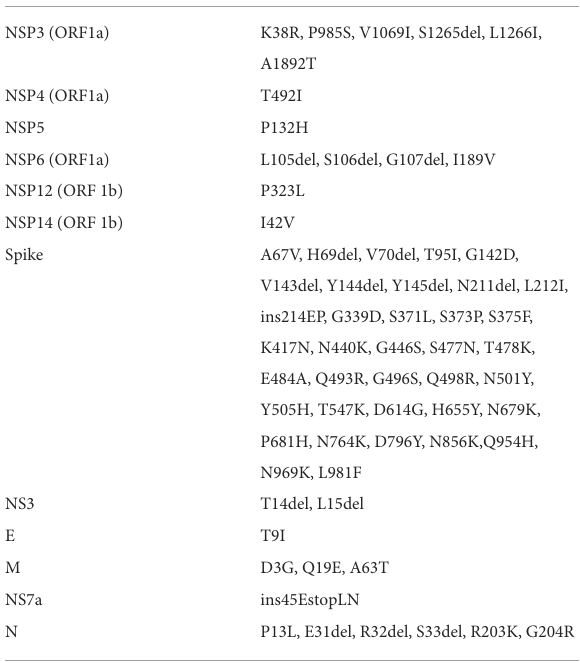
TABLE 3 List of mutations displayed in the different regions of the genome of SARS-CoV-2 in the sequence obtained in this study of